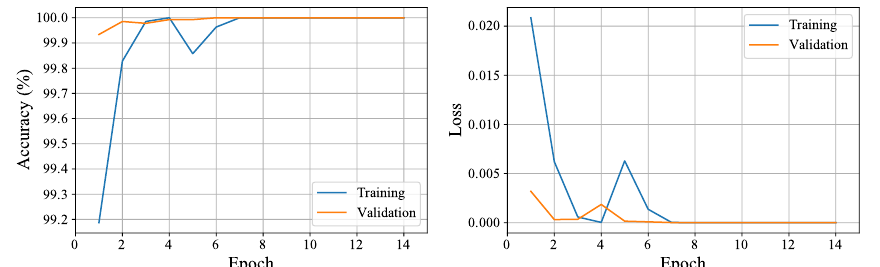
Figure 7. The accuracy and loss of training and validation datasets vs. epochs. The network converges after a few epochs to the optimum